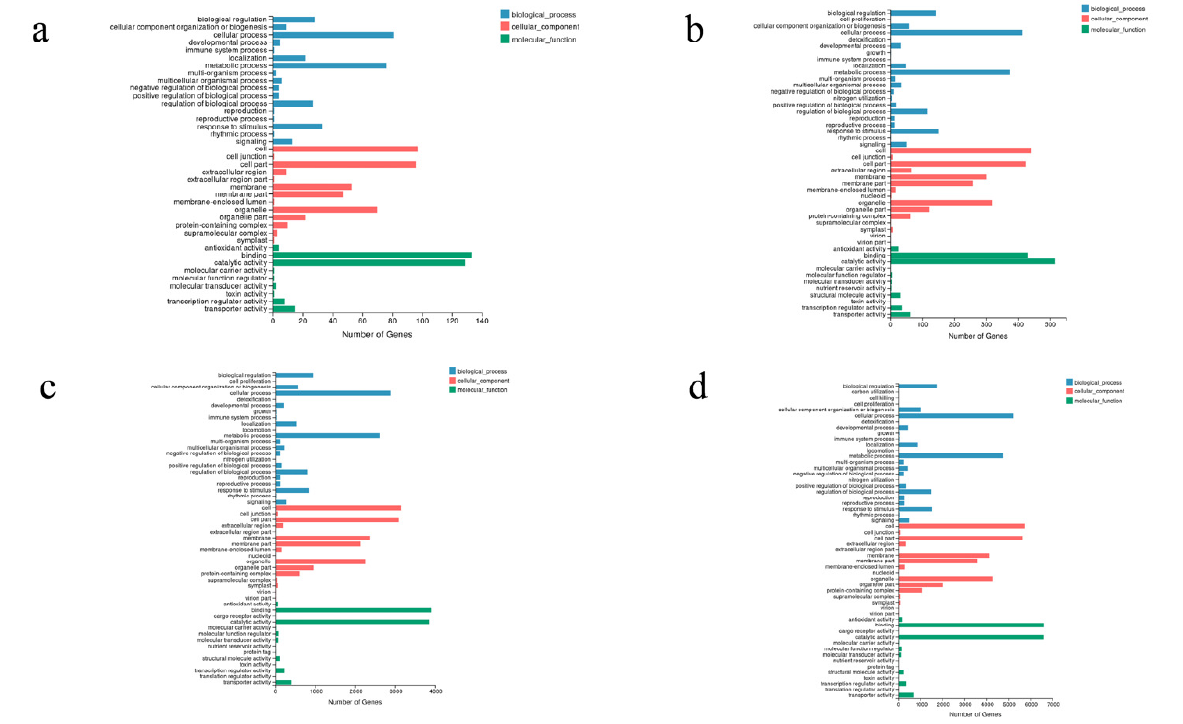
Figure 3. Gene ontology (GO) classifications of differential expression genes in four comparisons. Results are summarized in three main GO categories: biological process, cellular component, and molecular function: ( a ) CKD2/DD2; ( b ) CKL3/DL3; ( c ) CKD2/CKL3, and ( d ) DD2/DL3.